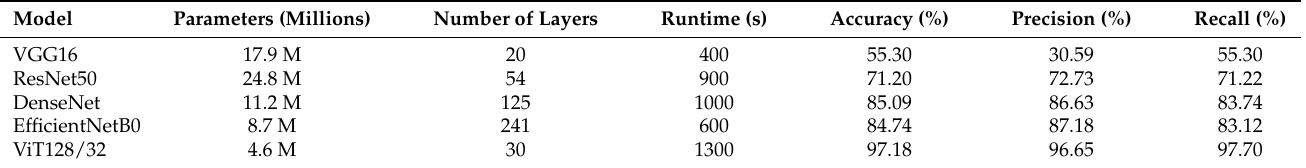
Table 7. Complexity Comparison of Derm-CGAN generated data on pre-trained and proposed